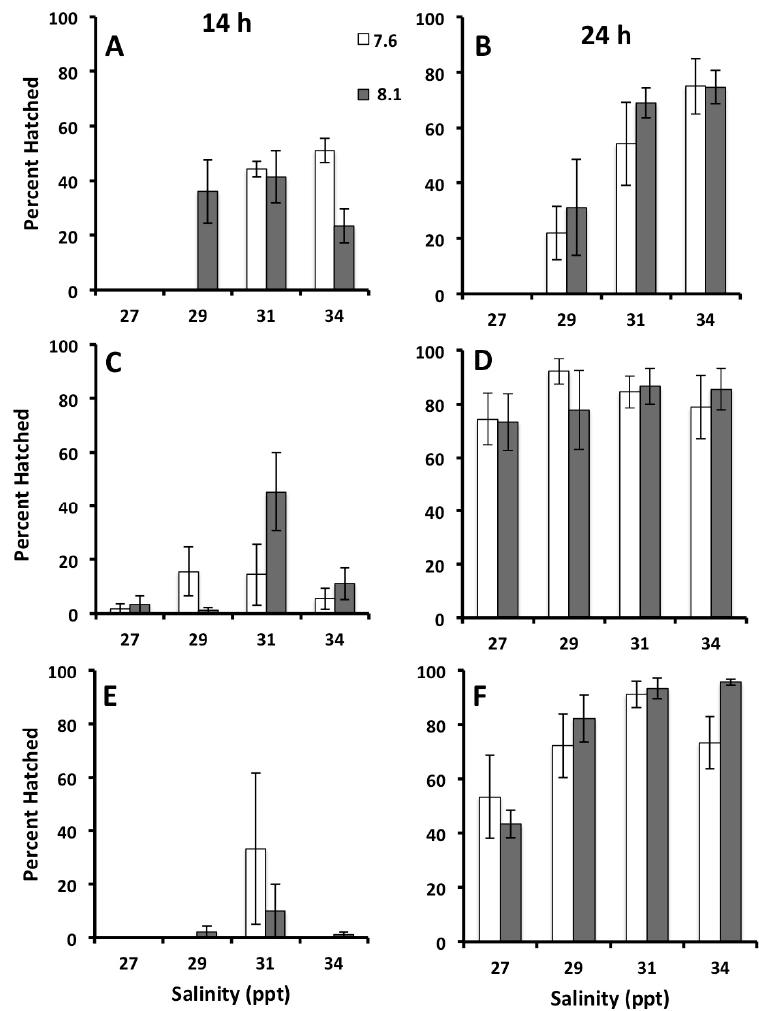
Figure 5. The effect of salinity (ppt) and pH on the percent of hatched A. cf. solaris embryos at 14 and 24 h post fertilization. Each bar represents the mean ( ± SE) of three replicate blocks. Panels ( A , B ) represent the first block. Panels ( C , D ) represent the second block and panels ( E , F ) represent the third block. The colour of the bars represents the pH treatments. Dark grey = pH 8.1 and white = pH